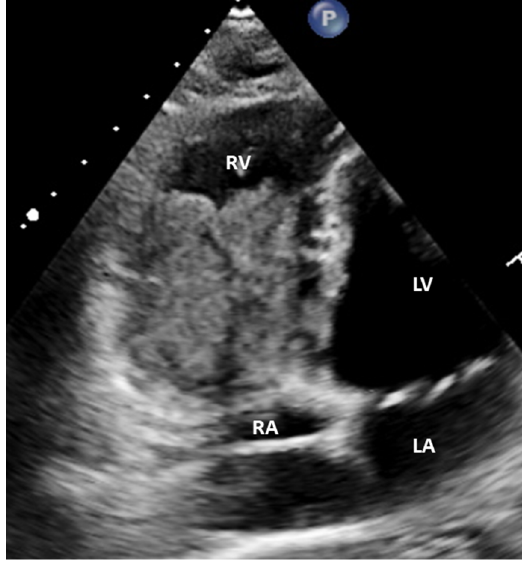
Figure 3. Echocardiogram, modified four chamber view: The tumor in RV has been enlarged occupying the majority of the chamber.